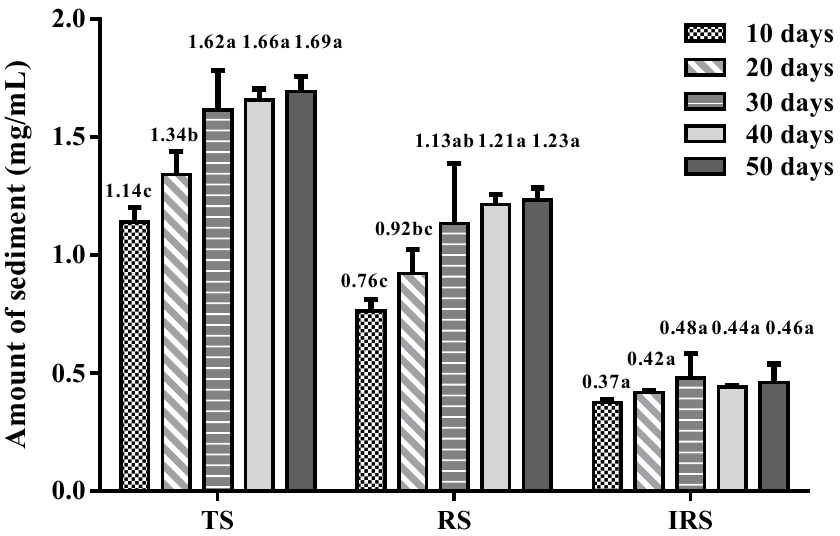
Figure 1. Total sediment (TS), reversible sediment (RS) and irreversible sediment (IRS) of ginseng extract during storage at 4 °C. The data are means of three replicates. Different letters in the column groups indicate a significant difference ( p < 0.05). Table 1. Observations of ginseng extract sediment formation during storage at 4 °C.